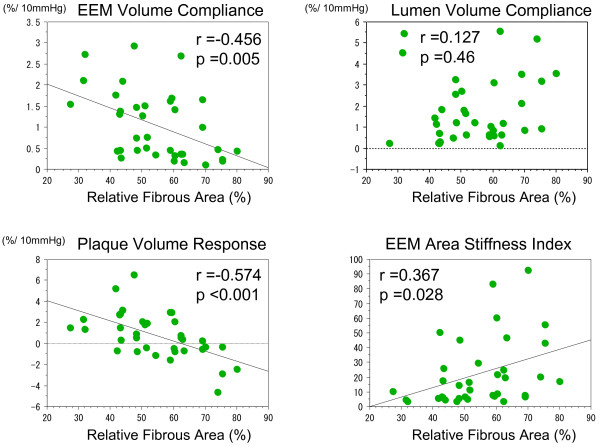
 Correlation among relative fibrous volume, mechanical properties and plaque behavior in the less calcified group. The EEM volume compliance, plaque volume compliance and EEM area stiffness index were significantly correlated with relative fibrous area whereas there was no significant correlation between lumen volume compliance and relative fibrous area. EEM: external elastic membrane.